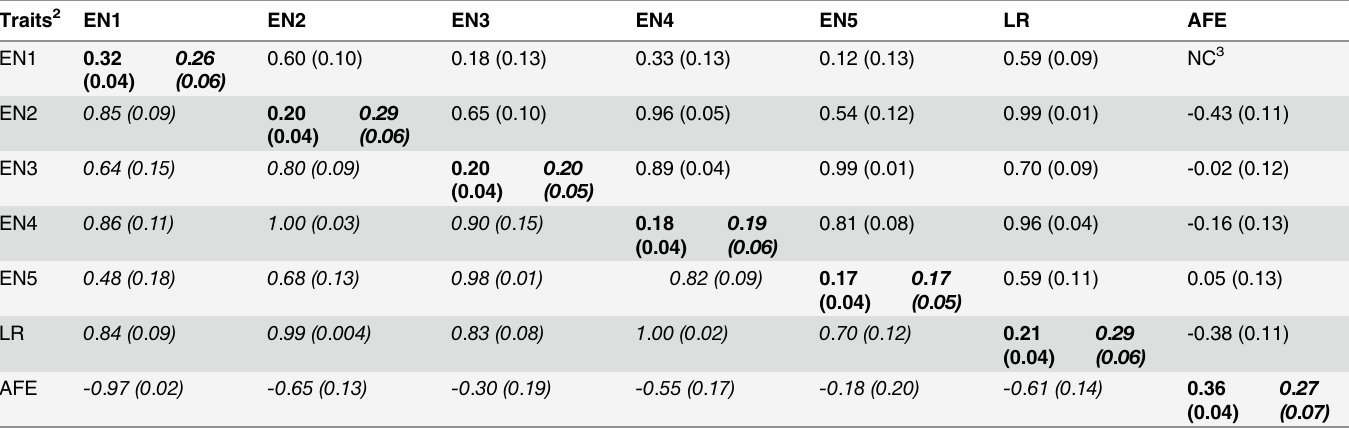
Table 3. Genetic parameters of egg number, egg laying rate and age at first egg 1 . Traits 2